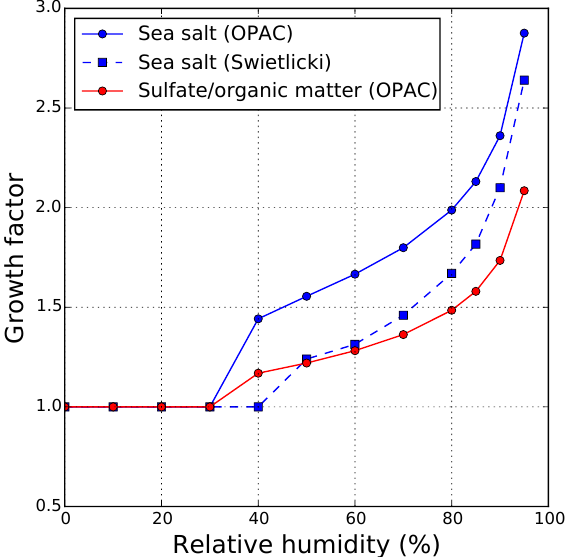
Figure 2. Location of the German weather service ceilometer sites at the end of 2017. The red spots indicate the ceilometer sites within 20km of IFS model grid point while the blue markers represent the rest of the network. Note that some of the sites are not in opera- tion during the period of study and therefore not included in this study. Elpersbüttel (see Sect. 4) is indicated in green. More detailed information of the ceilometer sites can be found in Table